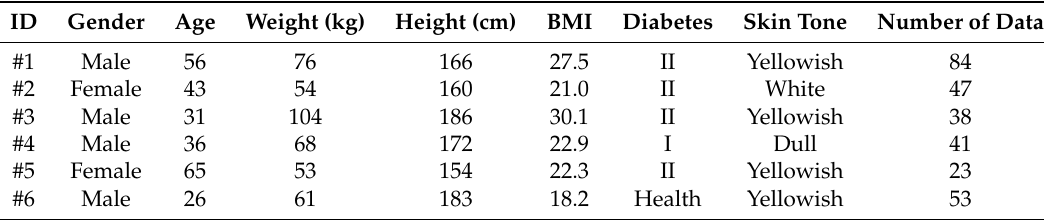
Table 3. The characteristics of each subject.